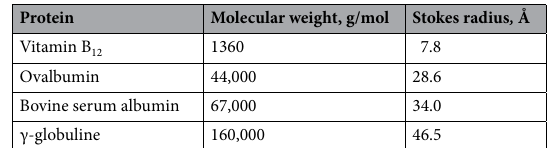
Table 1. Proteins for membrane